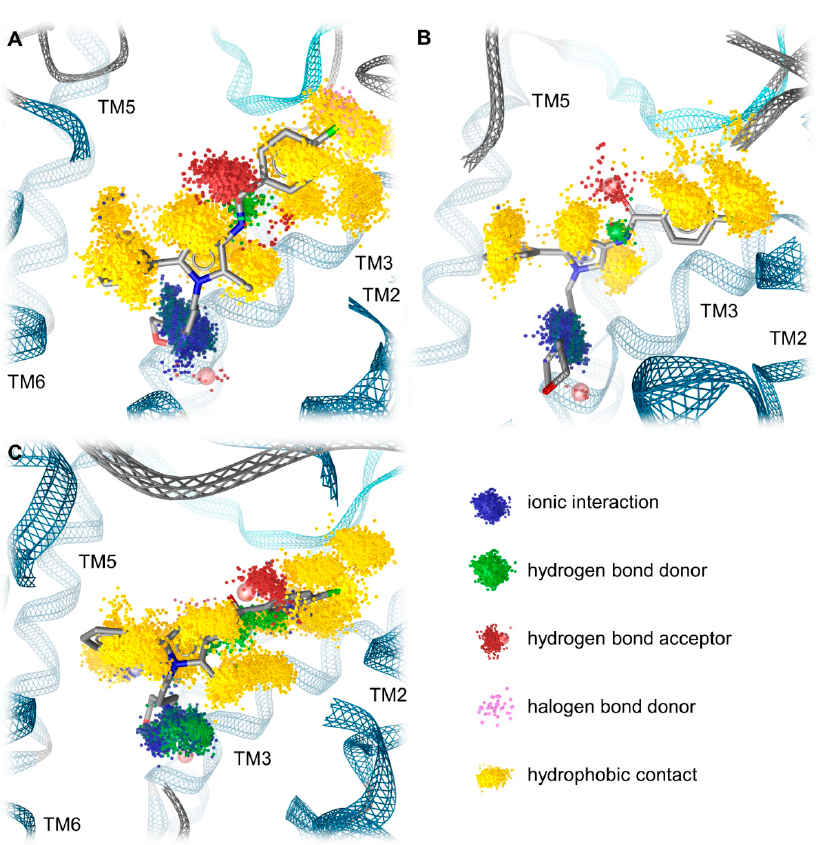
Figure 8. Dynamic 3D pharmacophores (dynophores) of Compound A–opioid receptor complexes. ( A ) KOR. ( B ) MOR. ( C ) DOR. Chemical feature clouds refer to interactions occurring over simulation time.